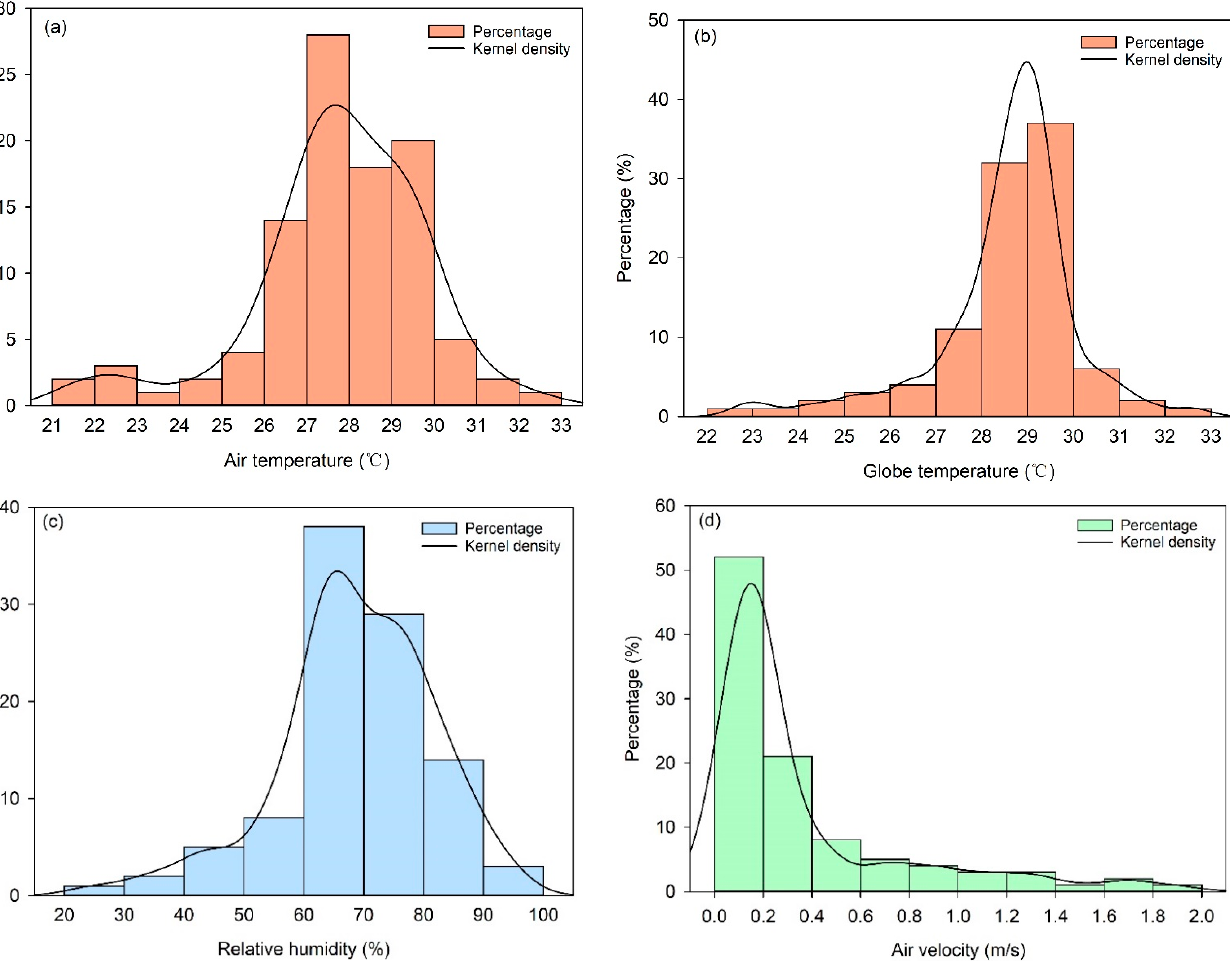
Figure 4. The distribution of indoor thermal environmental parameters: ( a ) air temperature; ( b ) globe temperature; ( c ) relative humidity; ( d ) air velocity.